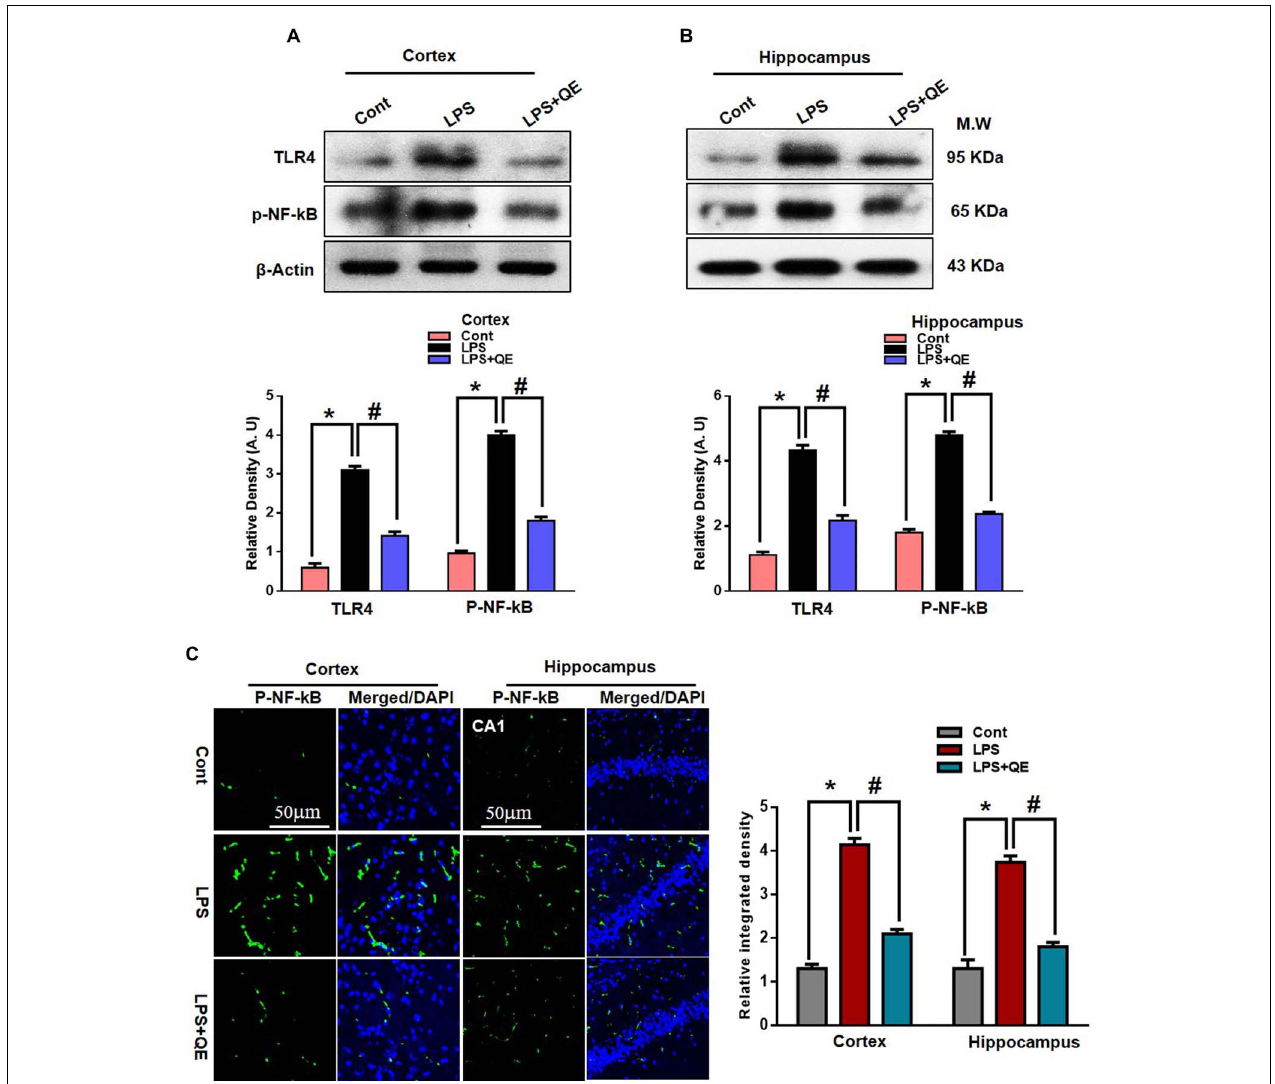
FIGURE 5 | Quercetin halts the LPS-induced activated TLR4/NFKB pathway. (A,B) Western blotting of TLR4 and p-NFKB proteins; their differences in the cortex and hippocampus of mouse brains are represented by a histogram. β -Actin was used as a loading control. The quantified density values are shown in arbitrary units (A.U.) as the means ± SEM for the respective shown protein (8 mice/group). (C) Representative immunofluorescence images and the quantified histogram of p-NFKB in the cortex and hippocampus of adult mice (5 mice/group). Magnified 10 × . Scale bar = 50 µ m. The expressed data are relative to the control. ∗ Significantly different from the control; # significantly different from LPS-treated group. Significance: P <